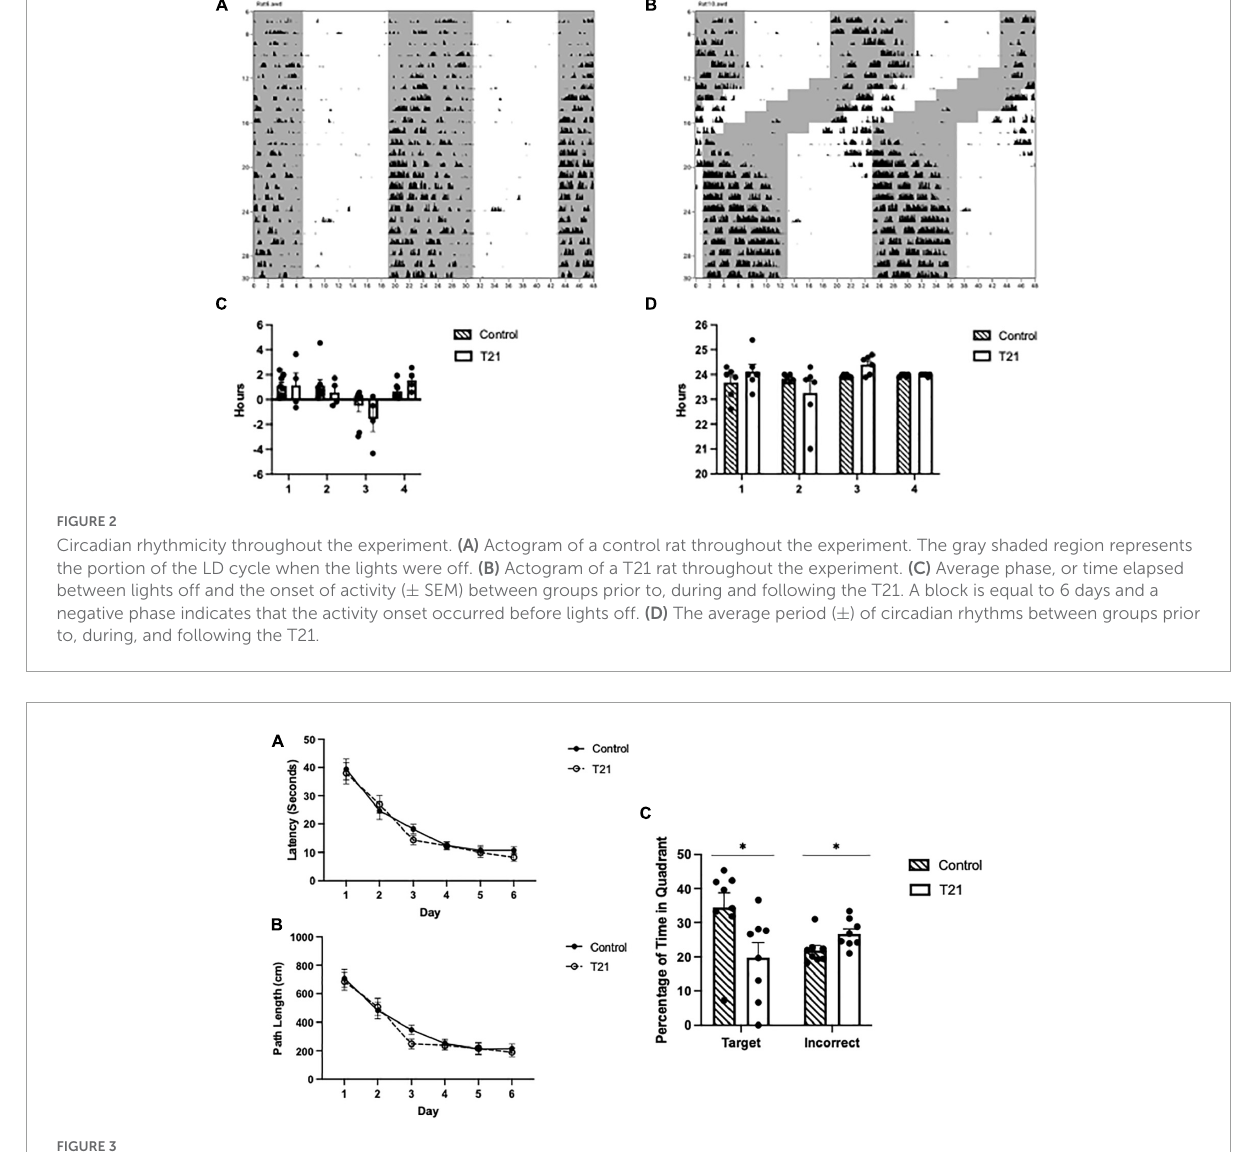
FIGURE3 Morris water maze acquisition and retention performance. (A) Average latency ( ± SEM) to reach the platform between groups for each day of acquisition training. (B) Average pathlength ( ± SEM) to reach the platform between groups for each day of acquisition training. (C) Average percentage of time spent in the target quadrant ( ± SEM) and the average percentage of time spent in the other three quadrants ( ± SEM) during the retention probe between groups. Control rats spent significantly more time in the target quadrant and significantly less time in the other quadrants than T21 rats, * p <